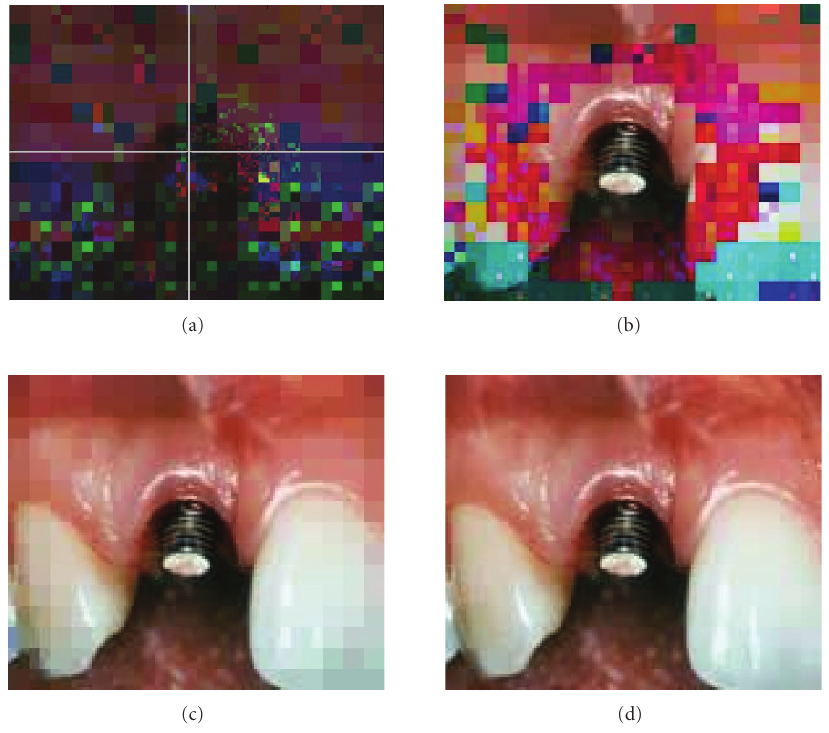
Figure 13: A decoded image with variable length of parity codes over noisy channel: (a) several error subblocks are detected in stage 1, (b) several error subblocks still are found in stage 2 indicating that the feedback message is incorrect or the channel condition becomes noisier. However, RoI is still error-free based on the UEP. (c) No error subblock is detected in stage 3 because the length of parity is adjusted again according to previous channel state, although there can still be some error. (d) The complete transmitted image with no error